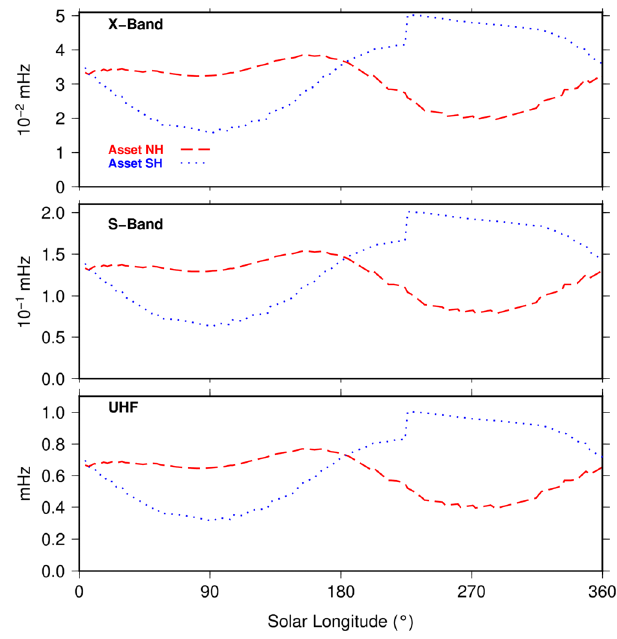
Fig. 11. Ionospheric signature on Doppler shift during a Martian year. Data extracted for different Ls, for a 20 (cid:3) elevation with respect to the asset at 06:00 SLT. The dashed red and dotted bleu lines correspond to an asset in the Northern and Southern hemispheres respectively. The ionospheric signature on Doppler shift is given for UHF (0.4 GHz, bottom), S-band (2 GHz, middle) and X-band (8 GHz, top) radio